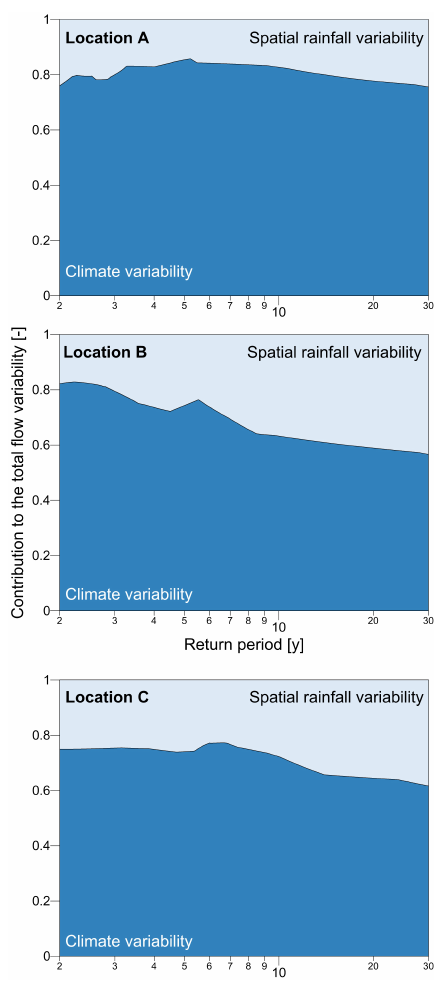
Figure 10. The ratio between the climate variability and the total flow variability for a given return period and for different locations within the urban drainage system is represented in dark blue. The remaining contribution is due to the addition of spatial rainfall vari- ability (light